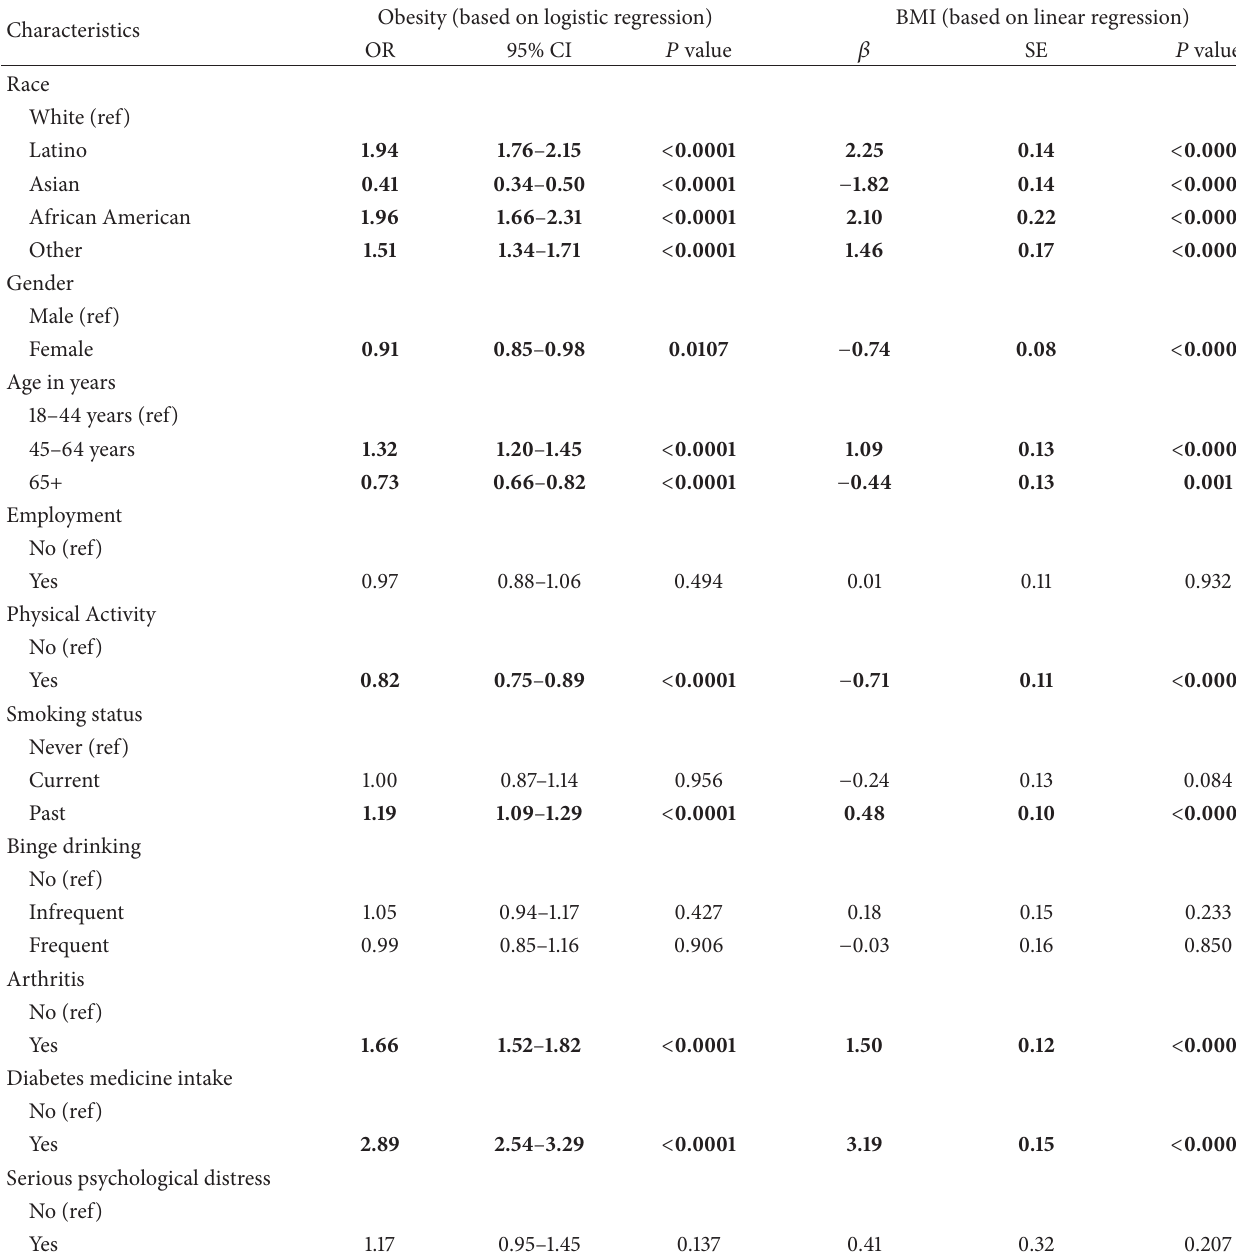
Table 2: Risk factors for obesity and BMI in U.S. adults, the 2011-12 CHIS ( 𝑛 =